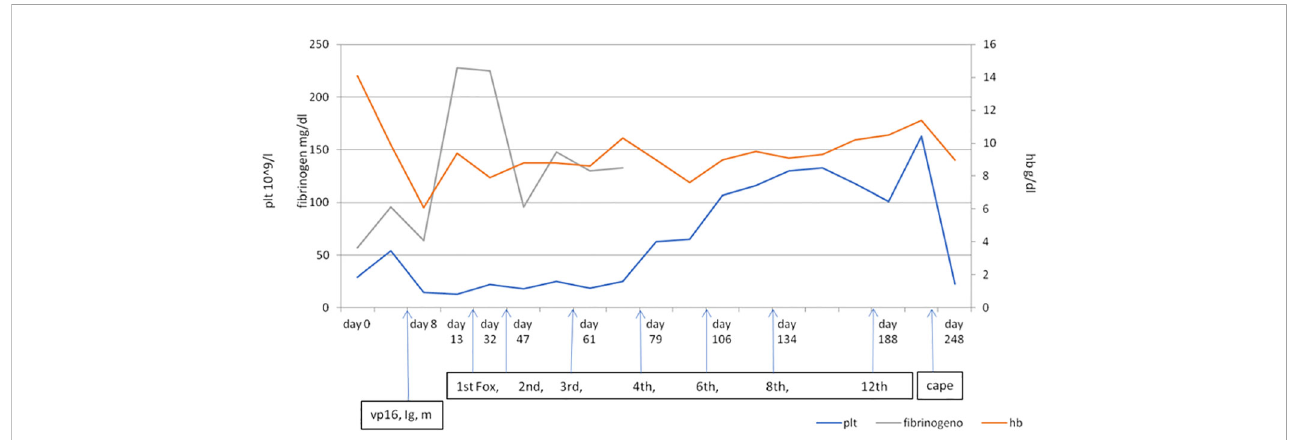
FIGURE 2 The trend of platelets, hemoglobin, and fi brinogen in relation to the treatments. Vp16, etoposide; Ig, immunoglobulin; m, methylprednisolone. First, 2nd, 3rd, 4th, 6th, 8th, and 12th cycles of Fox (Folfox); cape,